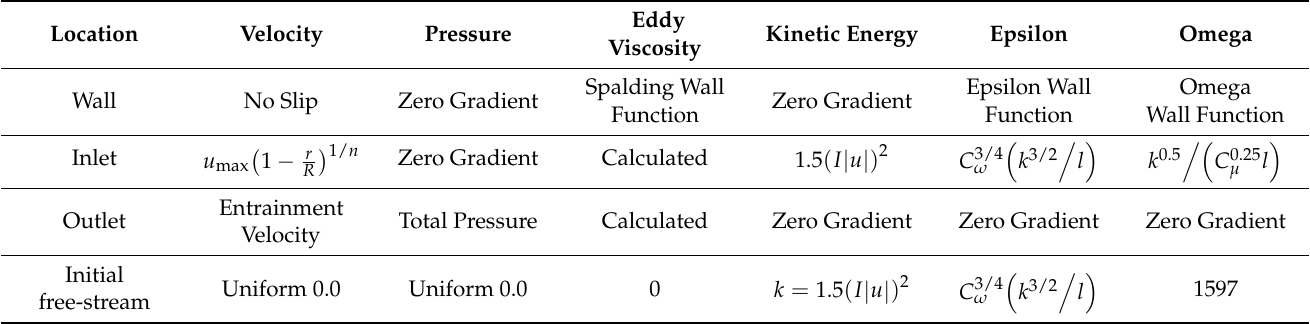
Table 3. Boundary conditions for Hardalupas et al.